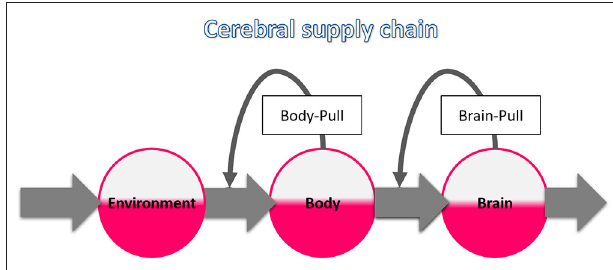
FIGURE 1 | The cerebral supply chain. Energy is transferred from the environment through the body to the brain, the end consumer of the supply chain. The characteristic of supply chains is the procurement on demand, also called pull principle. When the brain needs energy, the brain-pull demands it from the body. When the body needs energy, the body-pull demands it from the environment.